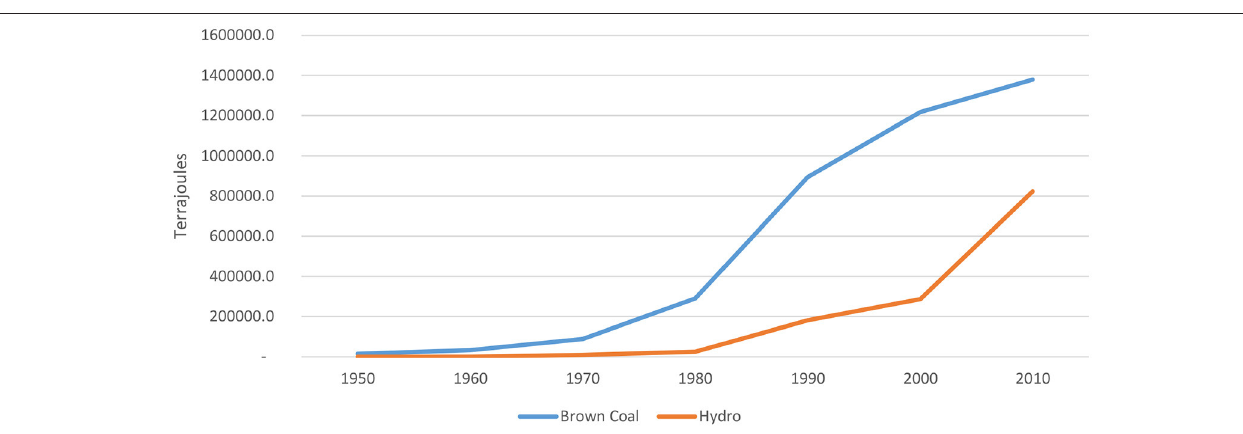
FIGURE 2 | Extracted energy from hydro and brown coal between 1950 and 2010 (Özkaynak et al.,